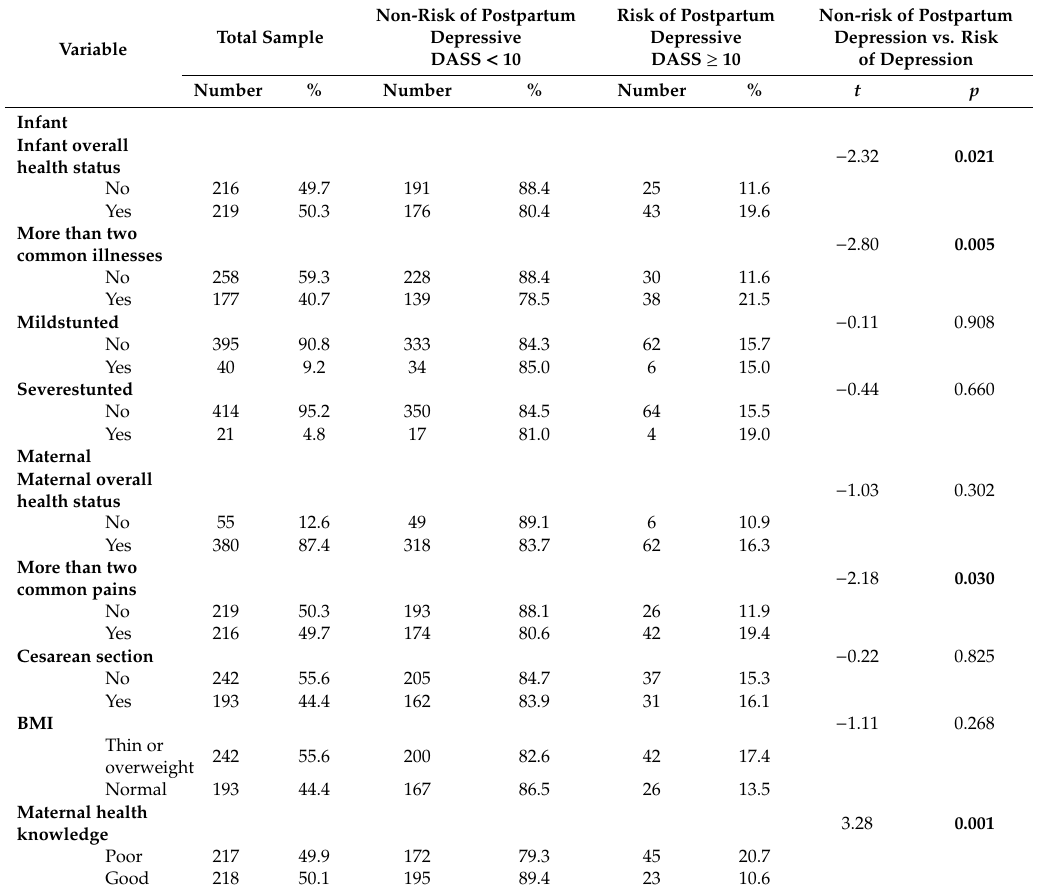
Table 1. Risk of postpartum depression of mothers in di ff erent groups of maternal and infant illness status and the level of maternal health